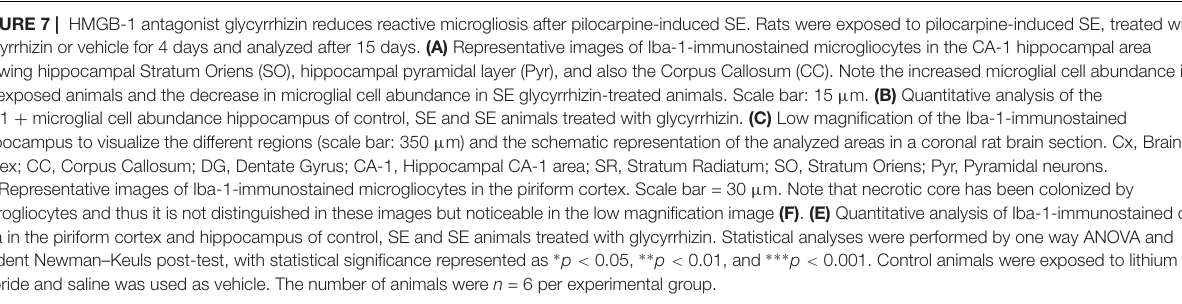
FIGURE 7 | HMGB-1 antagonist glycyrrhizin reduces reactive microgliosis after pilocarpine-induced SE. Rats were exposed to pilocarpine-induced SE, treated with glycyrrhizin or vehicle for 4 days and analyzed after 15 days. (A) Representative images of Iba-1-immunostained microgliocytes in the CA-1 hippocampal area showing hippocampal Stratum Oriens (SO), hippocampal pyramidal layer (Pyr), and also the Corpus Callosum (CC). Note the increased microglial cell abundance in SE exposed animals and the decrease in microglial cell abundance in SE glycyrrhizin-treated animals. Scale bar: 15 µ m. (B) Quantitative analysis of the Iba-1 + microglial cell abundance hippocampus of control, SE and SE animals treated with glycyrrhizin. (C) Low magnification of the Iba-1-immunostained hippocampus to visualize the different regions (scale bar: 350 µ m) and the schematic representation of the analyzed areas in a coronal rat brain section. Cx, Brain cortex; CC, Corpus Callosum; DG, Dentate Gyrus; CA-1, Hippocampal CA-1 area; SR, Stratum Radiatum; SO, Stratum Oriens; Pyr, Pyramidal neurons. (D) Representative images of Iba-1-immunostained microgliocytes in the piriform cortex. Scale bar = 30 µ m. Note that necrotic core has been colonized by microgliocytes and thus it is not distinguished in these images but noticeable in the low magnification image (F) . (E) Quantitative analysis of Iba-1-immunostained cell area in the piriform cortex and hippocampus of control, SE and SE animals treated with glycyrrhizin. Statistical analyses were performed by one way ANOVA and Student Newman–Keuls post-test, with statistical significance represented as ∗ p < 0.05, ∗∗ p < 0.01, and ∗∗∗ p < 0.001. Control animals were exposed to lithium chloride and saline was used as vehicle. The number of animals were n = 6 per experimental